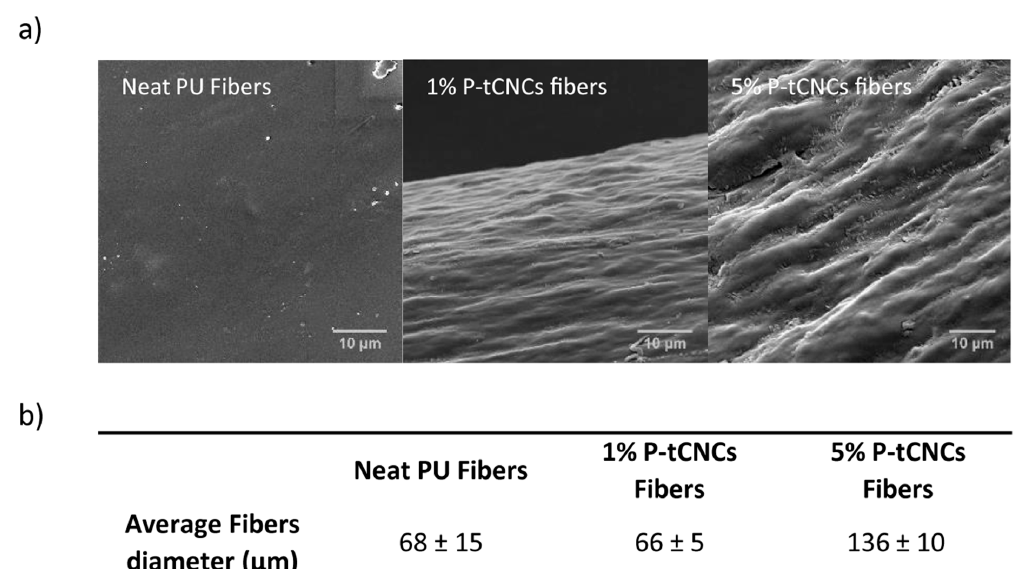
Figure 2. Schematic representation of the melt-spinning set-up.